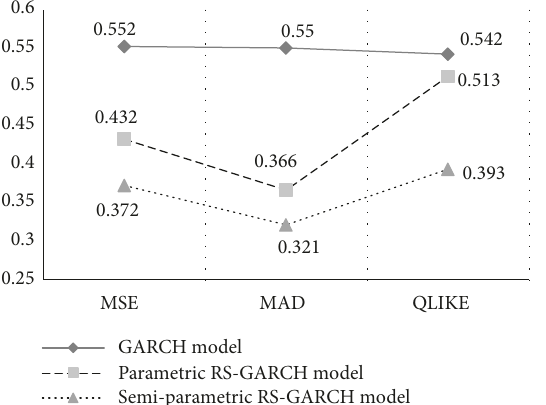
Figure 8: The model fitting error results out of sample period (SSE 50).